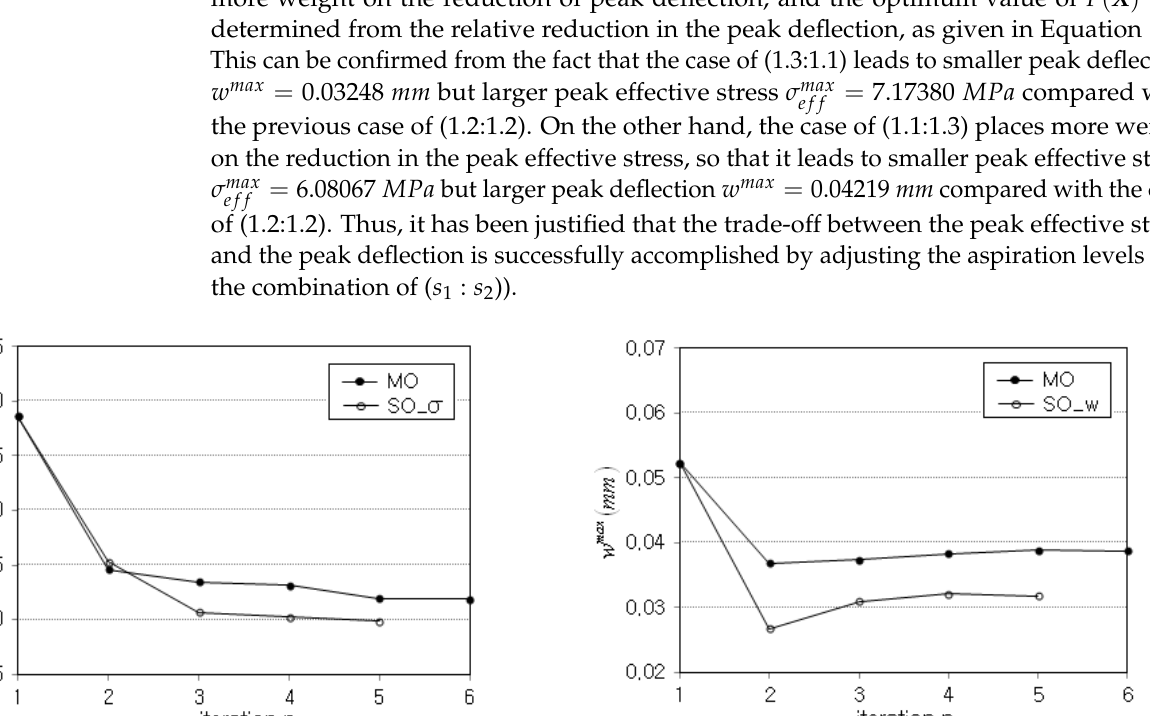
, ( b ) peak deflection w max . ef f